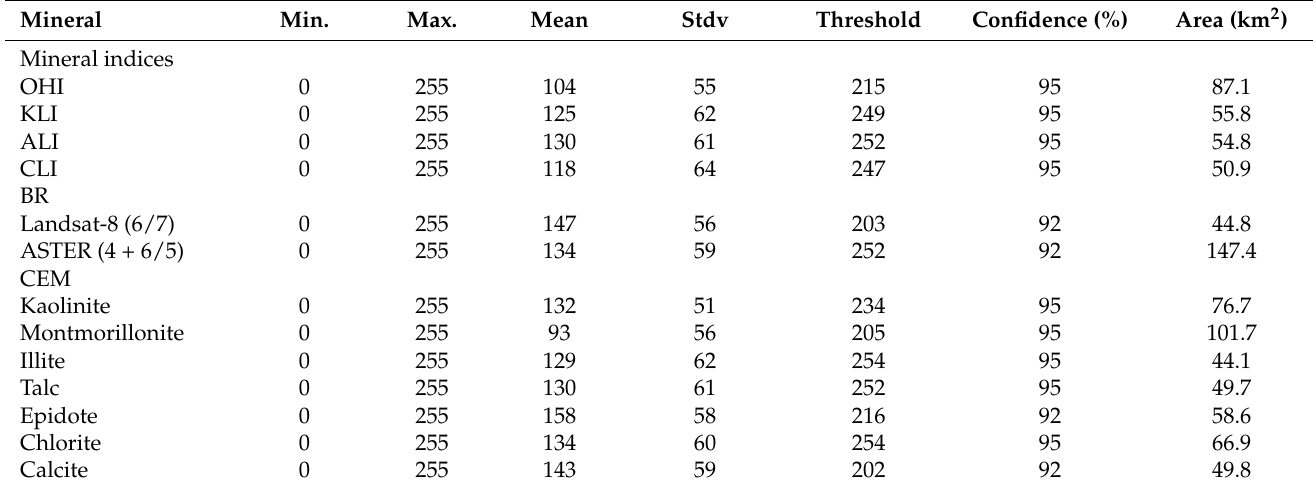
Table 3. The calculated thresholding which used to detect the target mineral from ASTER